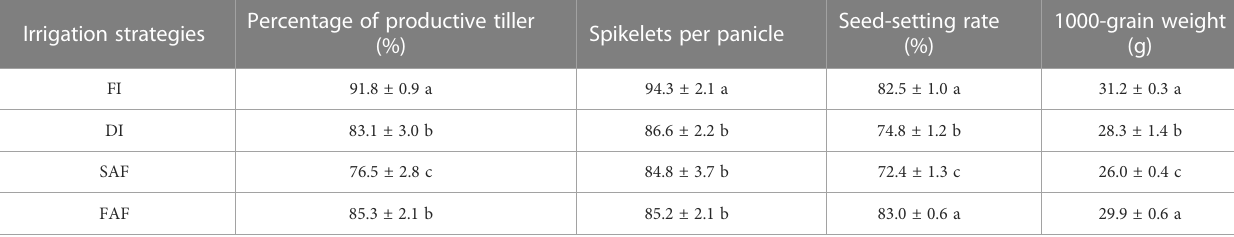
TABLE 2 Yield components in different irrigation strategy treatments.